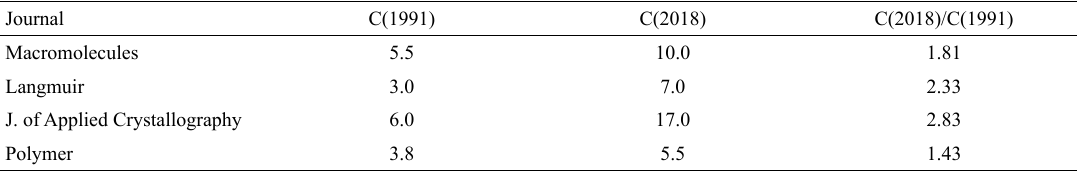
Table 2. Ratios of the number of articles related to SAS with respect to the total number of articles published in selected journals in 1991 and 2018. The third column reports the quotient between both ratios.